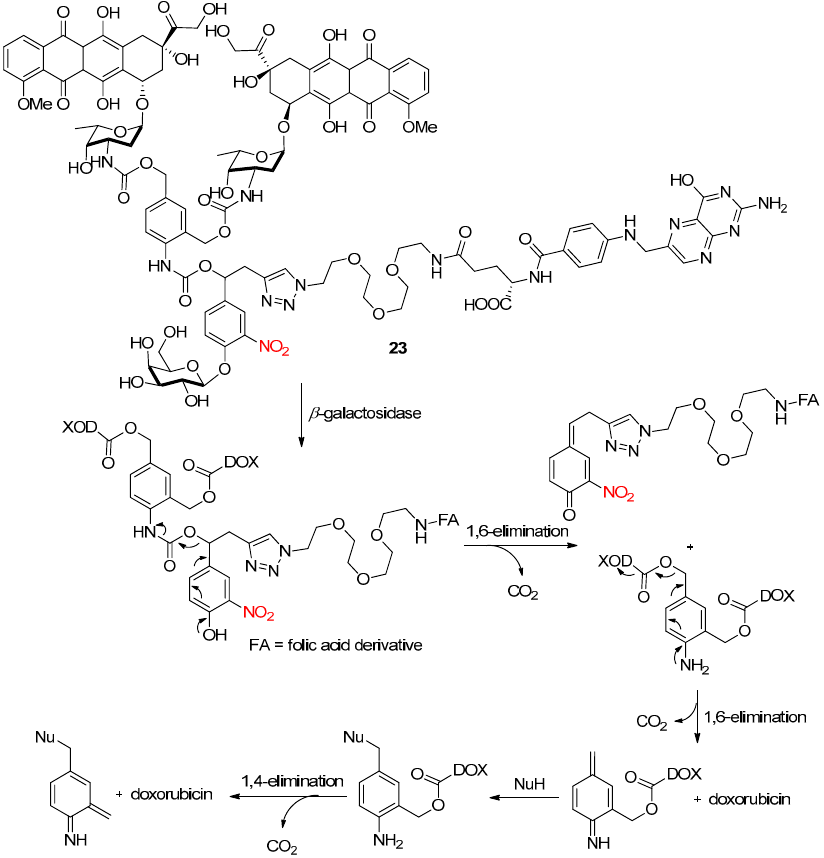
Scheme 26. β -Galactosidase-catalyzed release mechanism of the two drug units of doxorubicin from the chemical system